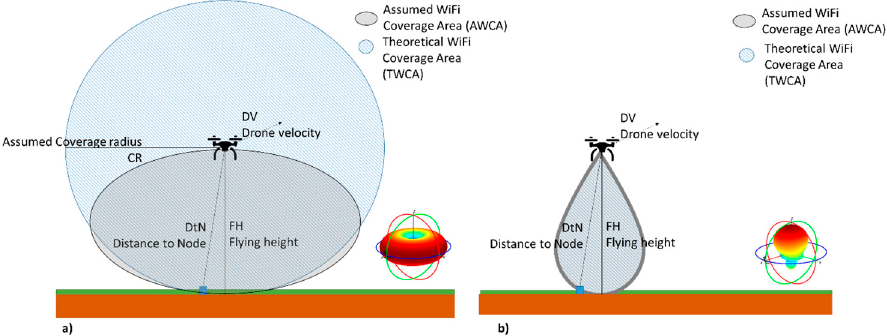
Figure 2. Area covered by the sensor antenna located on the drone: ( a ) Omnidirectional antenna case, ( b ) Directional antenna case.